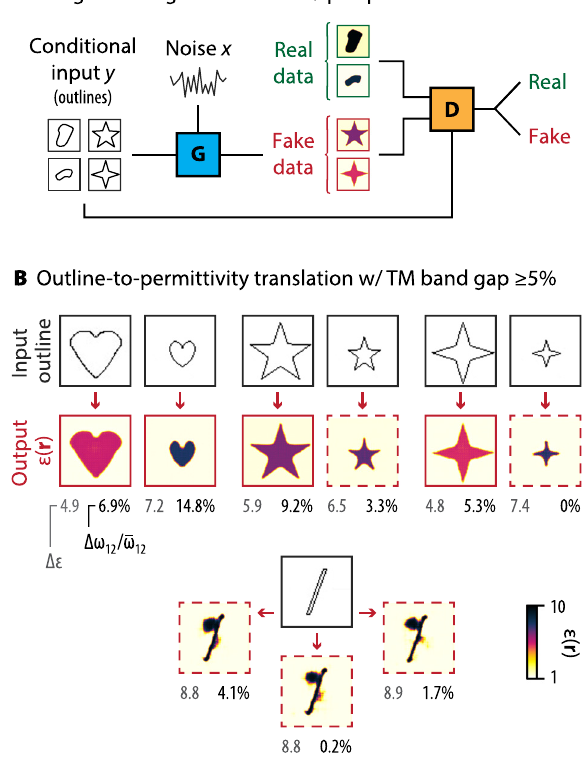
Figure 5: Image-to-image translation of photonic features. (A) Conditional GANs, as implemented e.g. by pix2pix [65], facilitate image-to-image translation by augmenting a conventional GAN (Figure 3) with a conditional input. (B) Using pix2pix , we trained a model to translate a discretized inclusion outline (black borders) to a permittivity profile (red borders) hosting a TM band gap. The permittivity contrast Δ ε ≡ max ϵ ( r ) − min ϵ ( r ) and the relative band gap Δ ω 12 / ω 12 , evaluated with MPB, are indicated below each design (dashed borders highlight cases where Δ ω 12 / ω 12 <